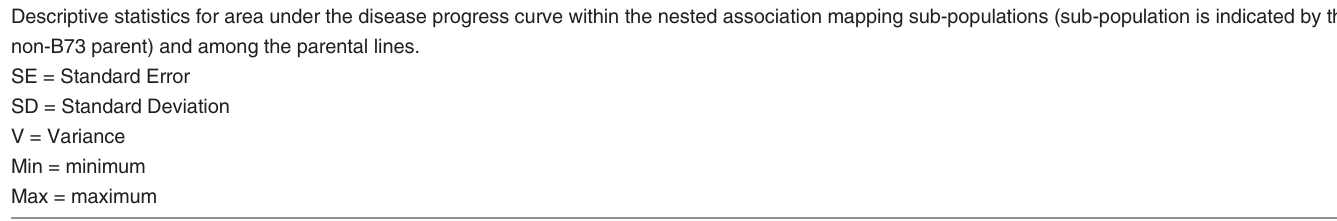
Descriptive statistics for area under the disease progress curve within the nested association mapping sub-populations (sub-population is indicated by the non-B73 parent) and among the parental